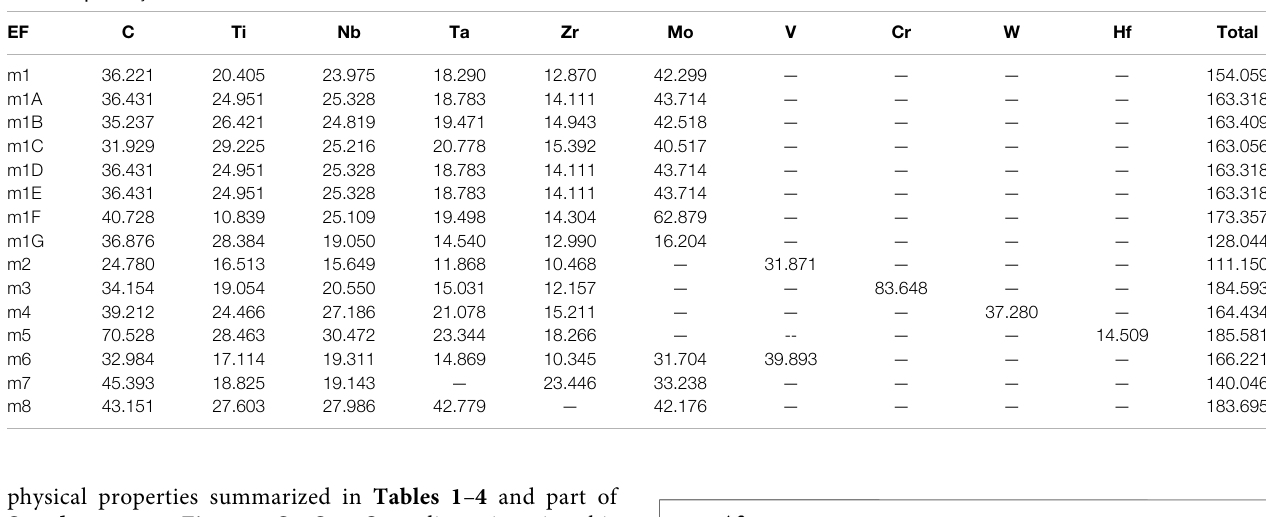
TABLE 4 | Density of states at Fermi level.